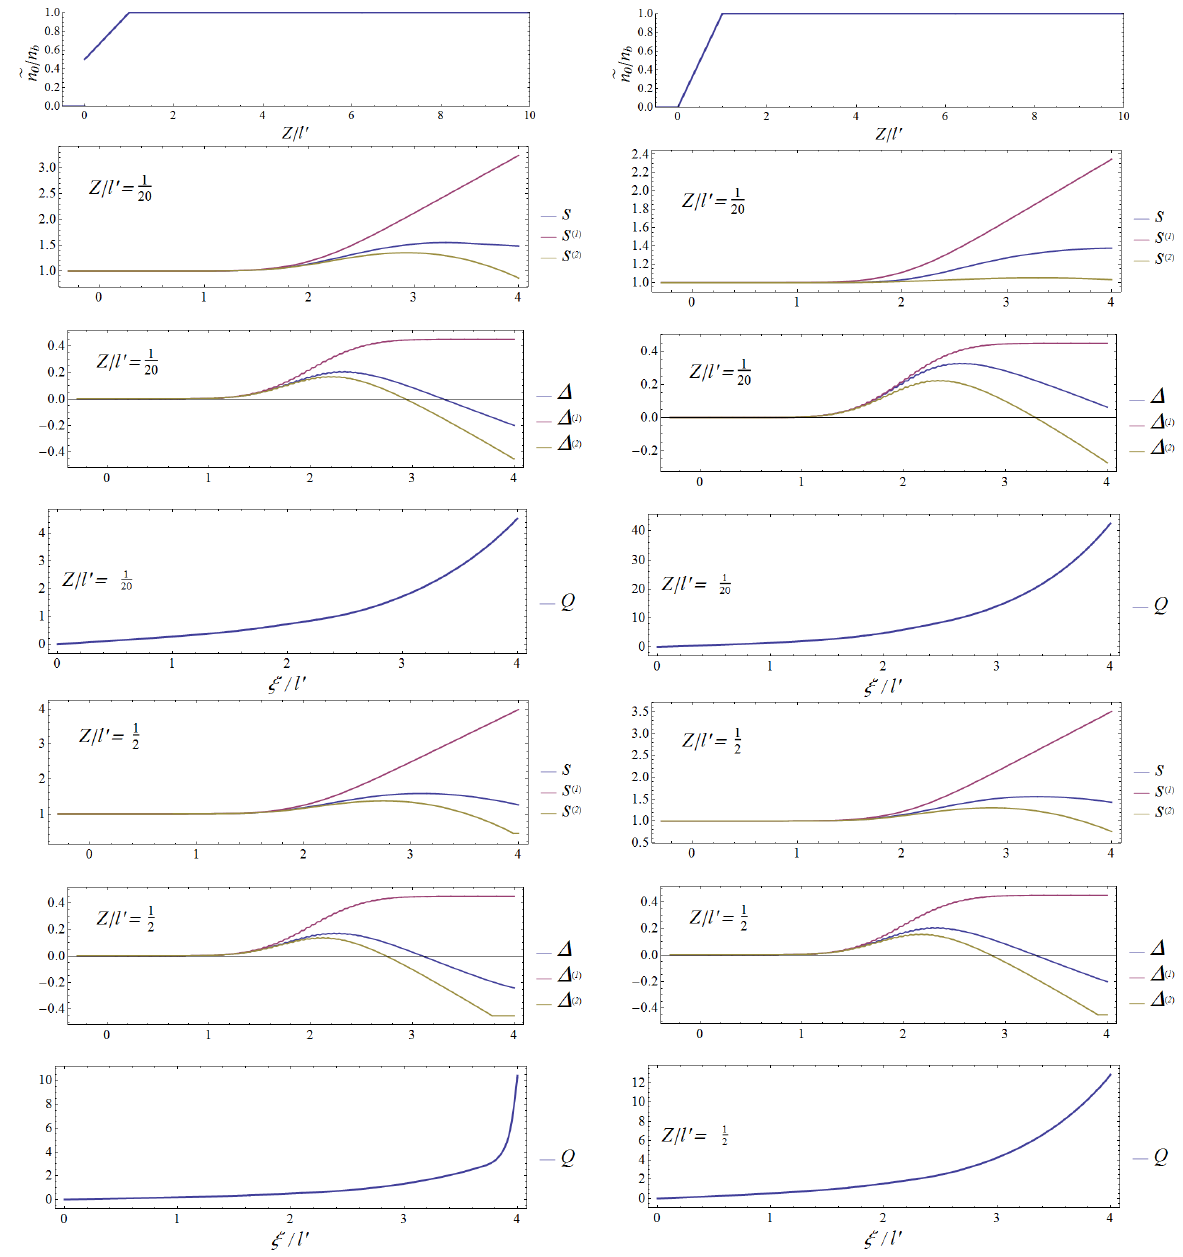
Figure 3. The initial electron densities (1), (2) of Figure 2 (first line; left and right, respectively). Below, assuming n b = 2 × 10 18 cm − 3 , we plot the corresponding s , ∆ , their upper and lower bounds s ( 1 ) , s ( 2 ) , ∆ ( 1 ) , ∆ ( 2 ) , and the function Q , vs. ξ during interaction with the pulse in Figure 1 for the same sample values, Z = l (cid:48) /20 and Z = l (cid:48) /2 of Z . The values Q 2 ( Z ) : = Q ( l , Z ) can be read off the plots. As can be seen, the bounds are much better for density (1); the values Q 2 ( Z ) (cid:46) 1 are consistent with all worldlines intersecting rather far from the laser-plasma interaction spacetime region. On the other hand, the large value of Q 2 ( Z ) for density (2) is an indication that worldlines intersect within or not far from the laser–plasma interaction spacetime region. Our computations lead to Q 0 ( l (cid:48) /20 ) = 10.64, Q 0 ( l (cid:48) /2 ) = with density (1) and Q 0 ( l (cid:48) /20 ) = 88.53, Q 0 ( l (cid:48) /2 ) = 32.35 with density